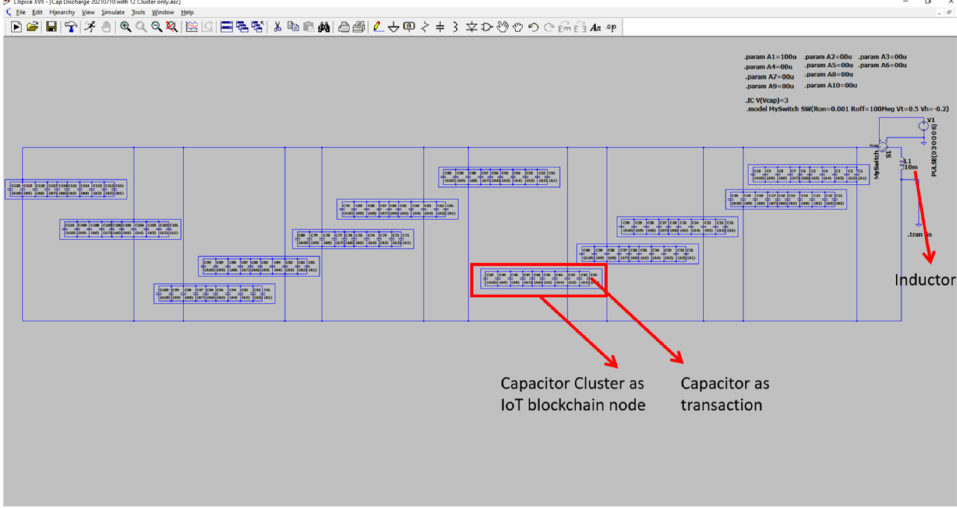
Figure 10. LTSPICE simulation LC circuit setup.